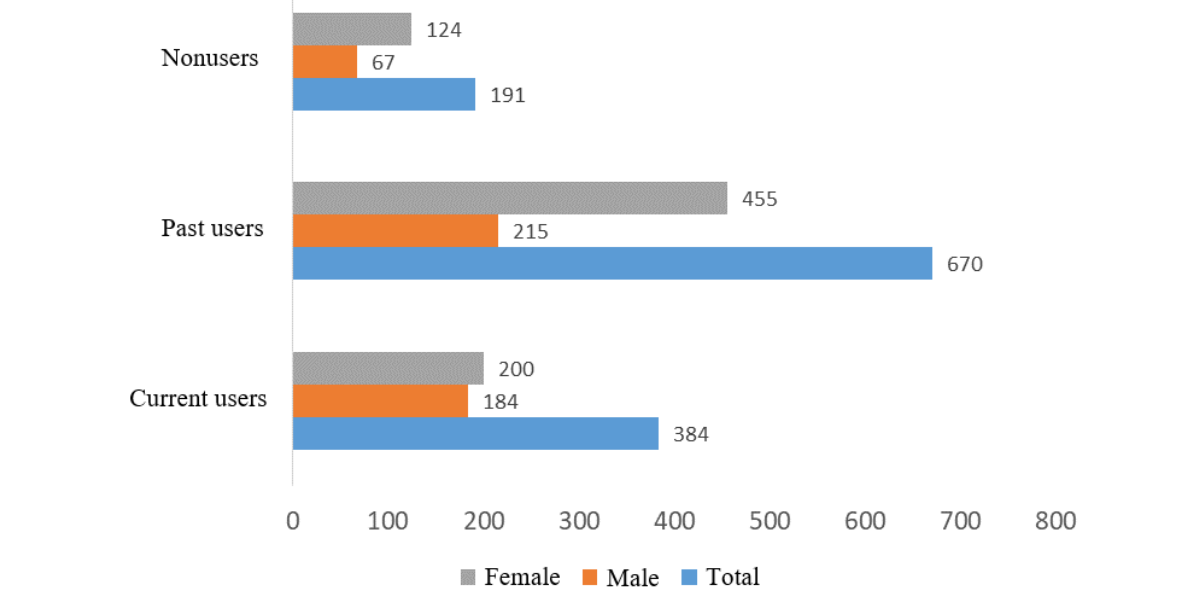
Figure 1. Number of each type of app user (male and